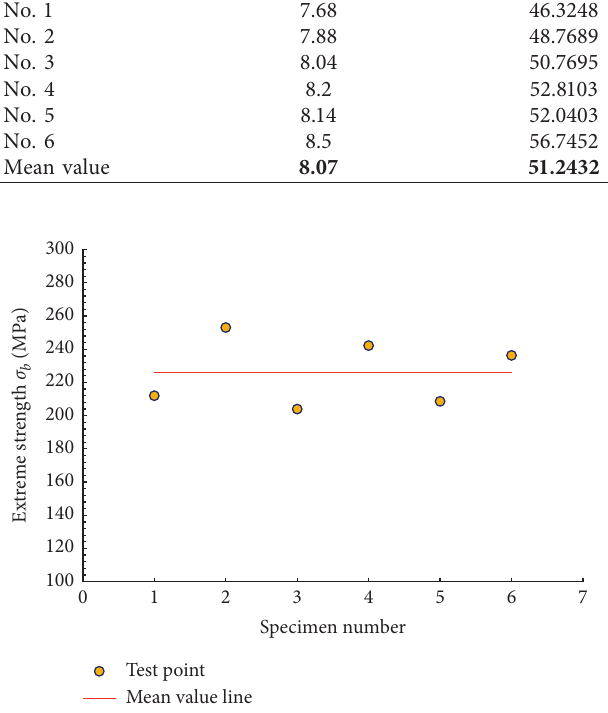
Figure 4: Distribution of test values of extreme strength of gray cast iron specimens.